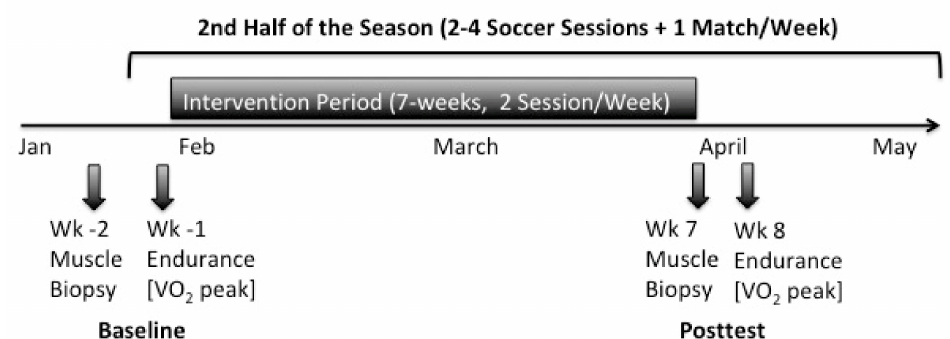
Figure 1. Timeline of endurance testing and muscle biopsy withdrawal during the study in the 2nd half of the